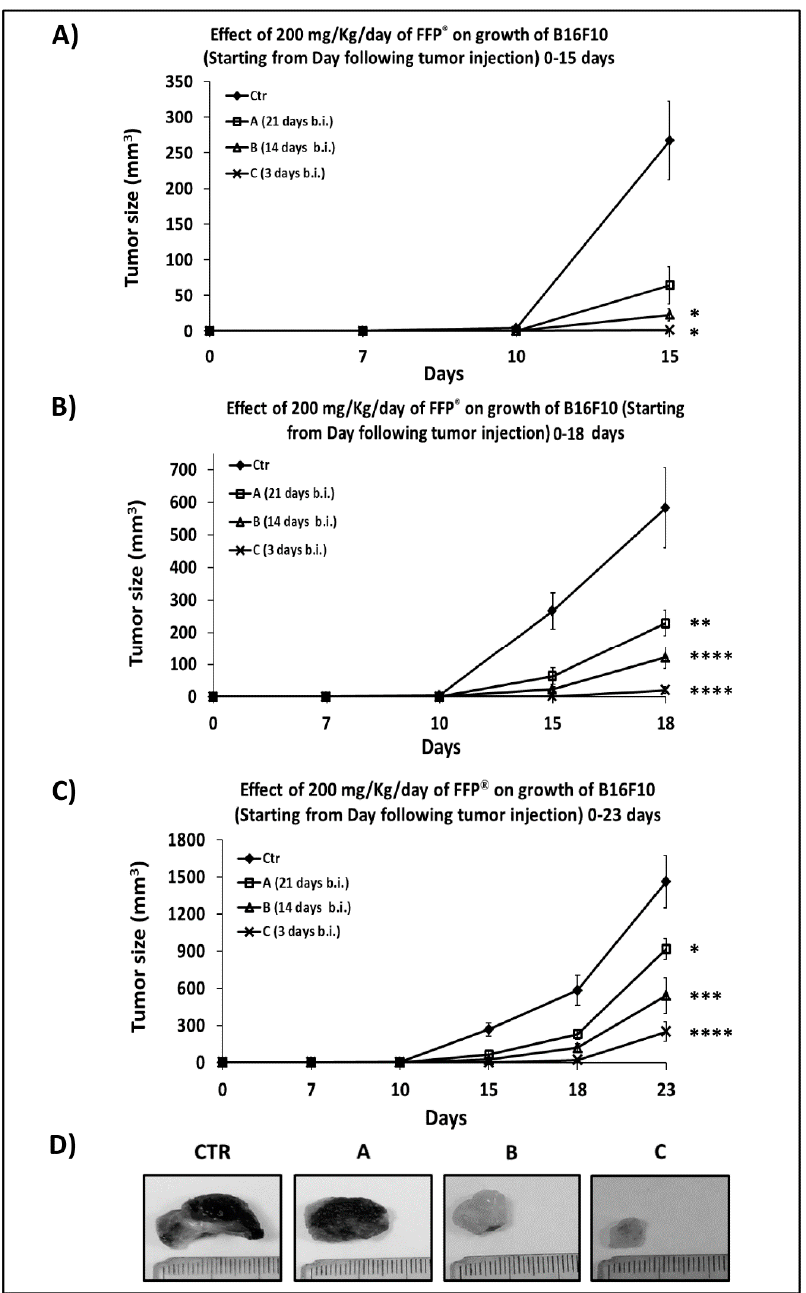
Figure 4. Combined preventive and therapeutic effects of 200 mg/Kg/day of FPP ® on growth of B16F10 in C57/BL mice 21 (group A), 14 (group B) and 3 (group C) days before inoculum. Preventive effect of 200 mg/Kg/day of FPP ® on growth of B16F10 in C57/BL mice treated 21 days before (group A), 14 days before (group B) and 3 days before (group C) cell inoculation. Mice were divided into 4 groups of 10 animals (control, A, B, C) inoculated with 100,000 B16F10 cells and treated only sublingually with FPP ® at the concentration of 200 mg/Kg/mouse every day without interruption until the sacrifice of the animals. ( A ) Effect of 200 mg/Kg/day of FPP ® on growth of B16F10 in C57/BL mice until 15 days after inoculation of cells. ( B ) Effect of 200 mg/Kg/day of FPP ® on growth of B16F10 in C57/BL mice until 18 days after inoculation of cells. ( C ) Effect of 200 mg/Kg/day of FPP ® on growth of B16F10 in C57/BL mice until 23 days after inoculation of cells (animal sacrifice). ( D ) Size and color of melanoma in mice at sacrifice in control, A, B and C groups. Data are expressed as means ± SE. * p < 0.05, ** p < 0.003, *** p < 0.0004, **** p < 0.0001.